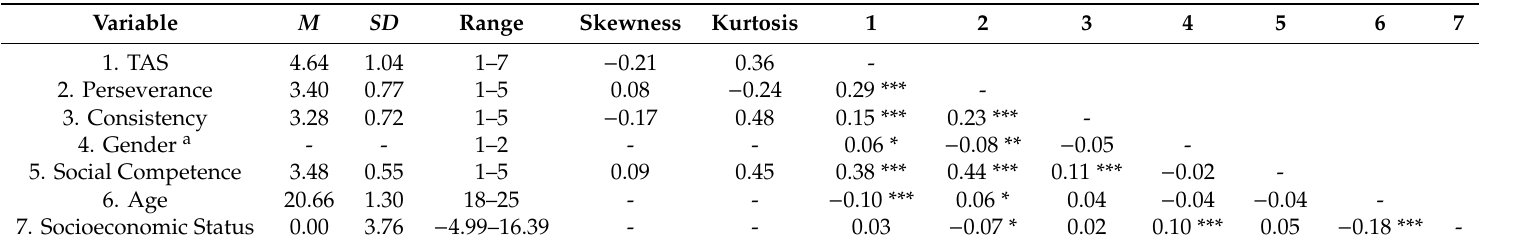
Table 1. Descriptive statistics and bivariate correlations of study variables for Chinese undergraduate